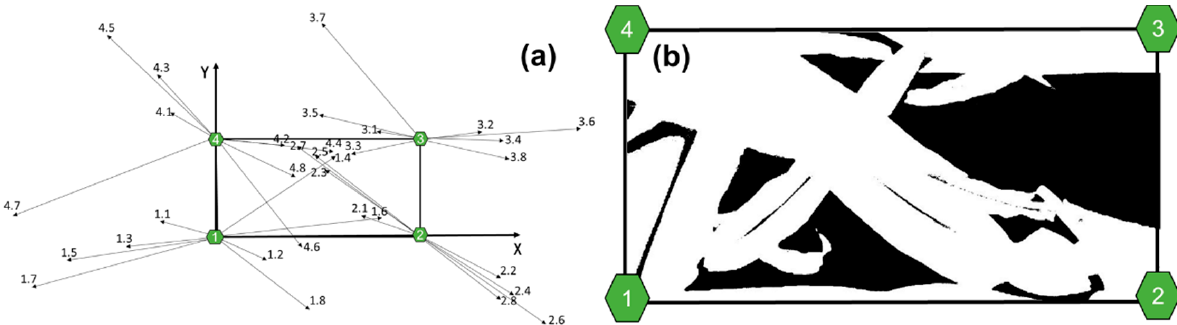
Figure 6. Spatial structure of maize canopy. ( a ) Spatial distribution of maize leaves; ( b ) maize canopy projection. 1–4 indicate the distribution of maize selected for the experiment in the micro-scale spatial range.